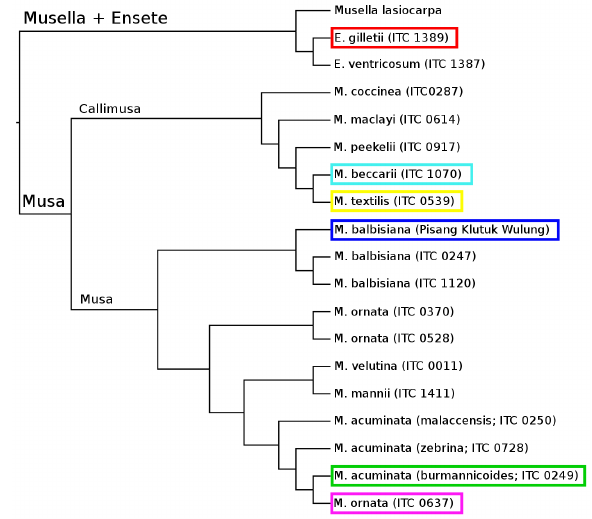
Figure 1. Evolutionary relationship between species of Musa- ceae family. Phylogeny estimated from ITS data using BioNJ. Six genomes selected for repeat analysis are highlighted.